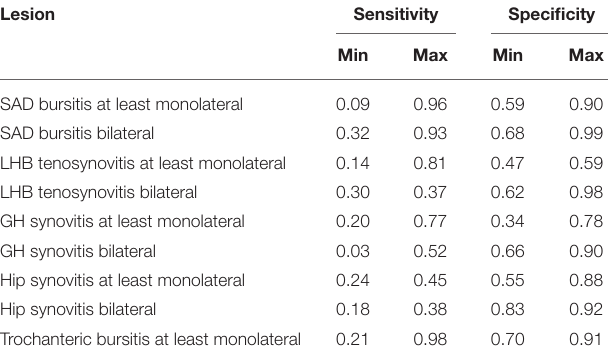
TABLE 6 | Performance of ultrasound lesions to detect PMR.